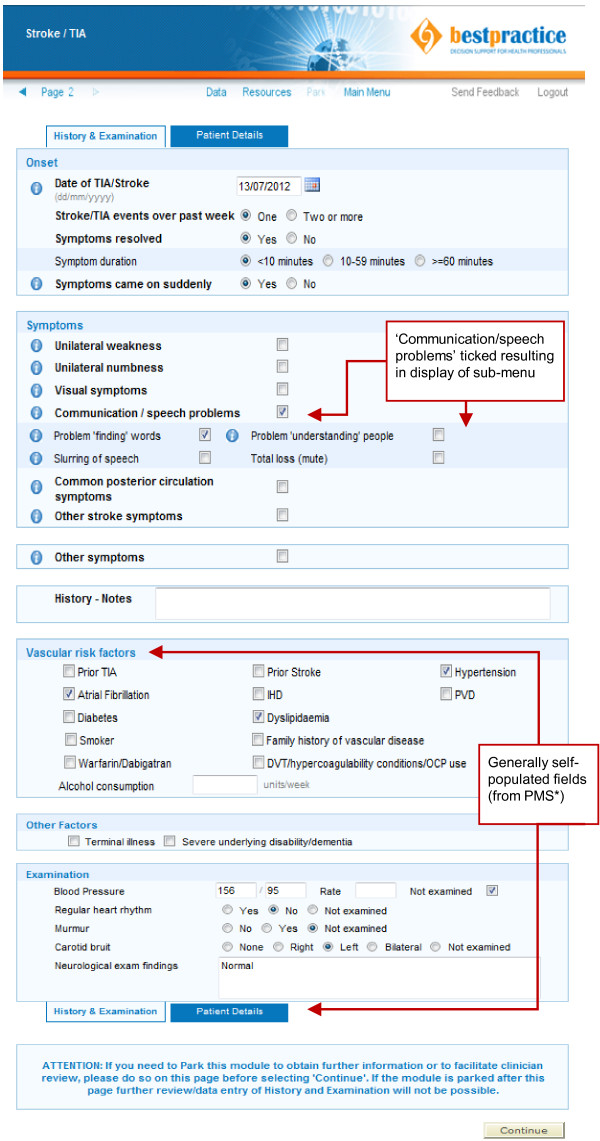
TIA/Stroke electronic decision support data entry form depicting a sample case. *PMS = Practice Management System i.e. GP electronic patient records.